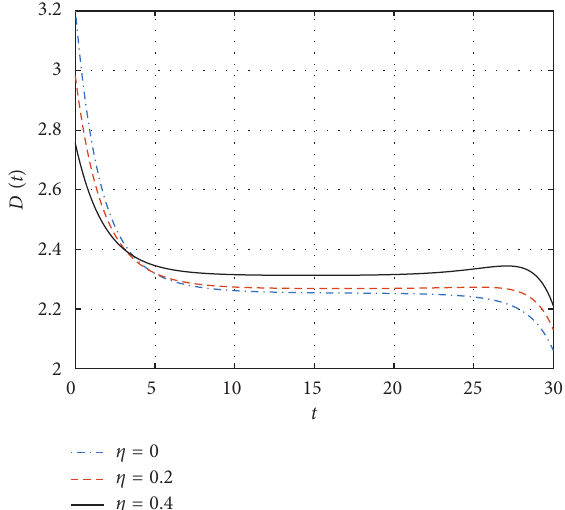
Figure 3: The optimal dynamic pricing strategy with different values of parameters η .